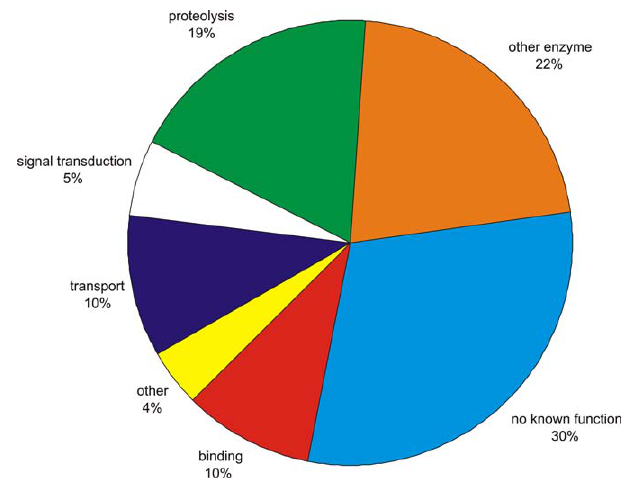
Figure 1. Functional Composition of Candidate Female Reproductive Proteins Functional composition of 241 secreted and transmembrane proteins in D. arizonae female reproductive tracts based on GO terms